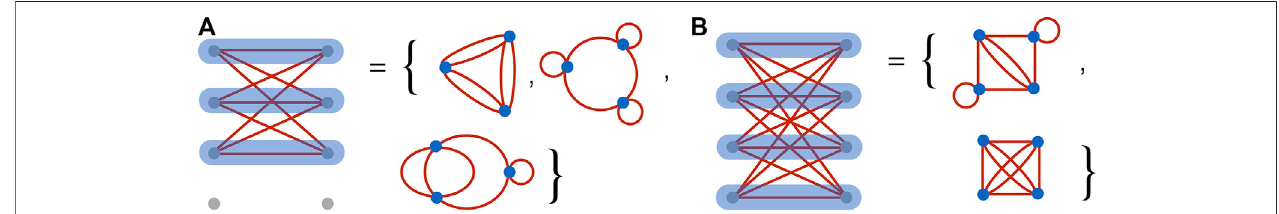
Frontiers in Astronomy and Space Sciences |